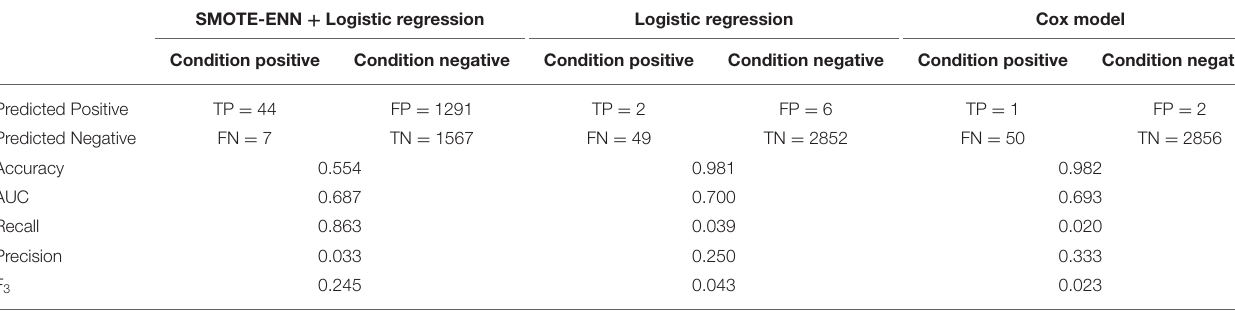
TABLE 3 | Prediction performance of the logistic regression analysis and the Cox proportional hazards model.